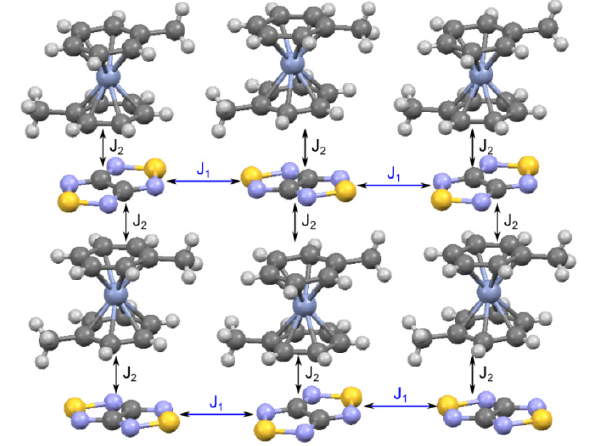
Figure 22. Simplified magnetic motif of heterospin RA salt 76 .